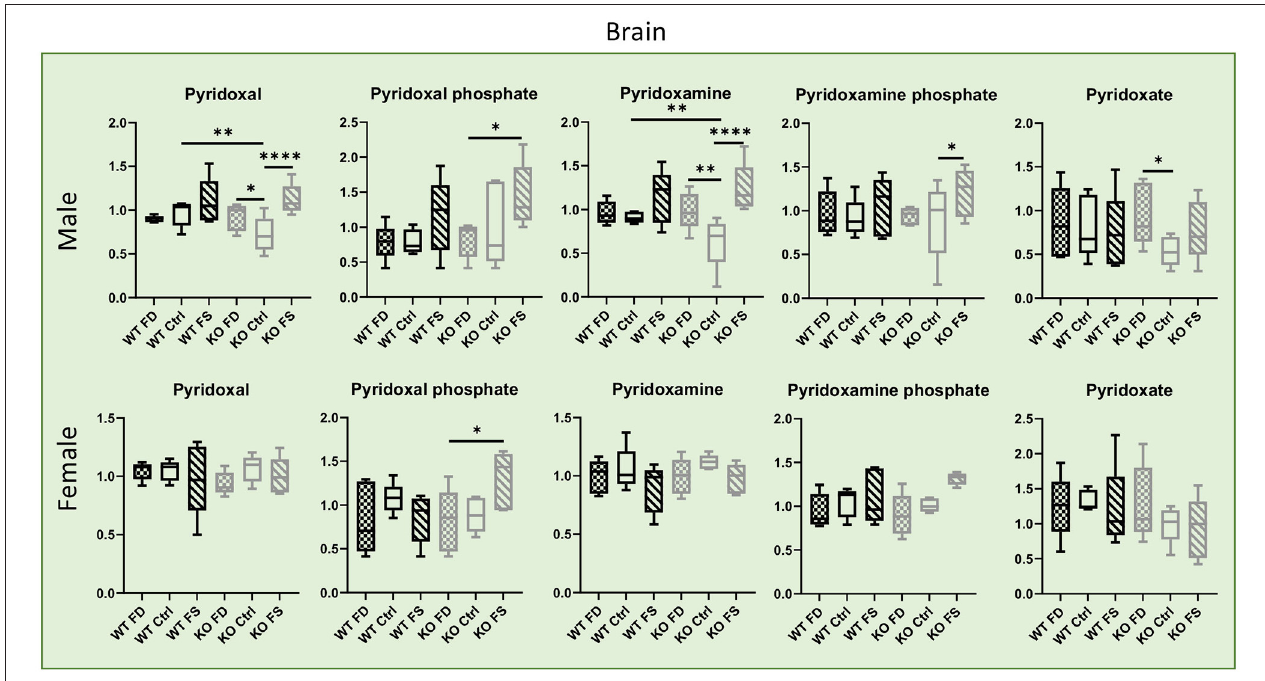
FIGURE 8 | In mouse brains, concentrations of B 6 vitamers and their phosphorylated forms show no difference between males and females. Significant increase in phosphorylated forms by FA over-supplementation was found in CerS6 KO male brains, but less in female. Data show minimum and maximum with bar at median value, n = 5. Checked bars, FD diet; solid bars, Ctrl diet; striped bars, FS diet. WT is shown in black, and KO is shown in gray. * p < 0.05; ** p < 0.01; **** p < 0.0001; determined by ANOVA